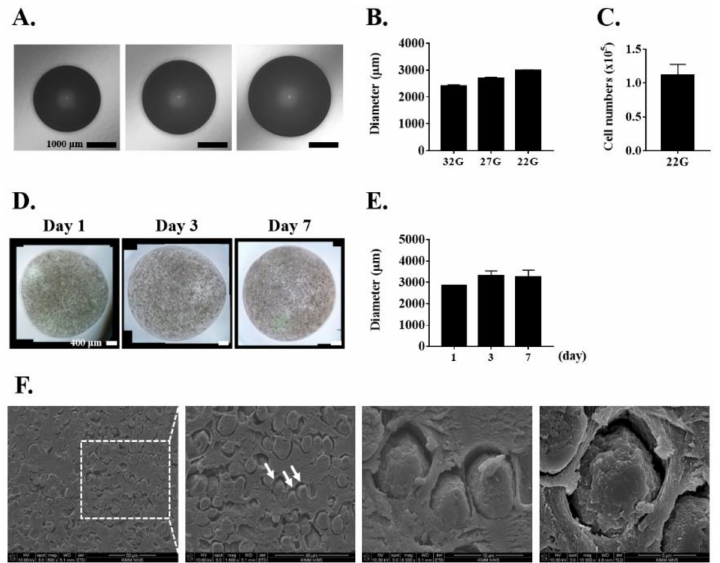
Figure 1. Characterization of alginate microbeads. ( A ) Alginate microbeads fabricated with various nozzle sizes. Scale bar = 1000 µ m. ( B ) Measurement of alginate microbeads size. ( C ) The number of cells in alginate microbeads fabricated with a 22 G nozzle. ( D ) The images of alginate microbeads fabricated with a 22 G nozzle at different culture times. Scale bar = 400 µ m. ( E ) Measurement of alginate microbeads size at different culture times. ( F ) The encapsulated cells indicated by white arrows were measured using SEM imaging at day 1. Scale bar = 40 µ m. Results are representative of at least three independent experimental repeats. Bars indicate mean ±